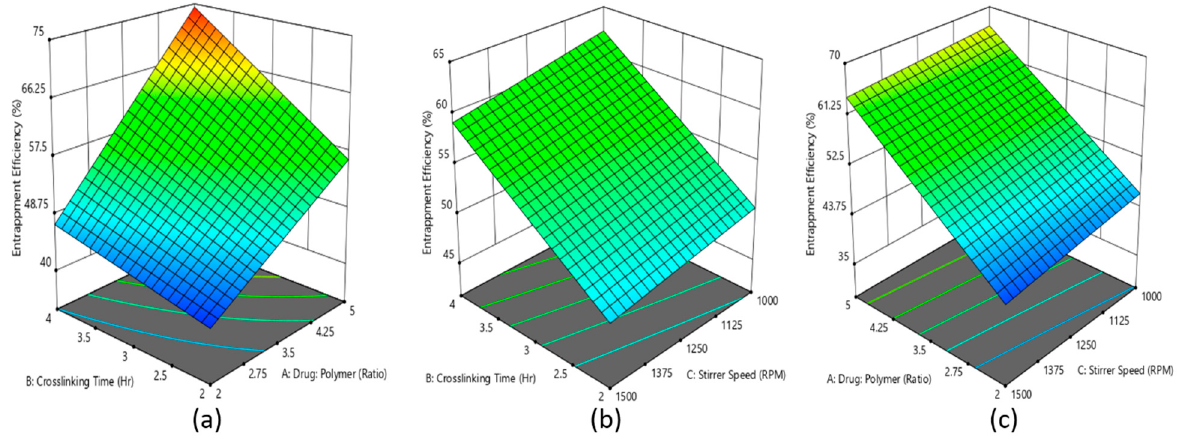
Figure 2. Effect of the interaction of ( a ) drug–polymer ratio, ( b ) crosslinking time, and ( c ) stirrer speed is represented in the 3D surface plot on percentage entrapment efficiency of rivastigmine nanoparticle formulation.